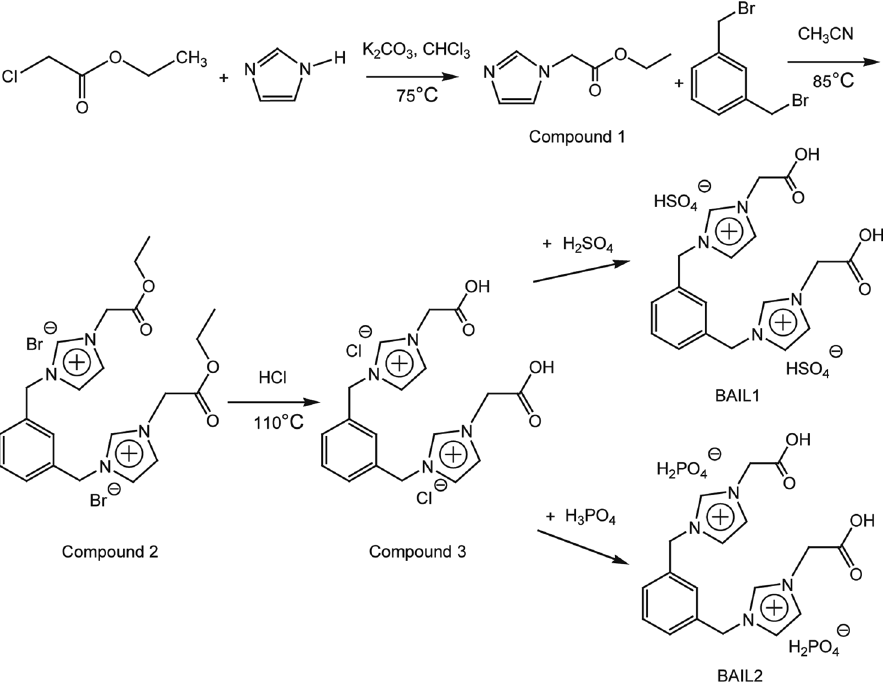
Figure 1. Synthesis schemes of BAIL1 and